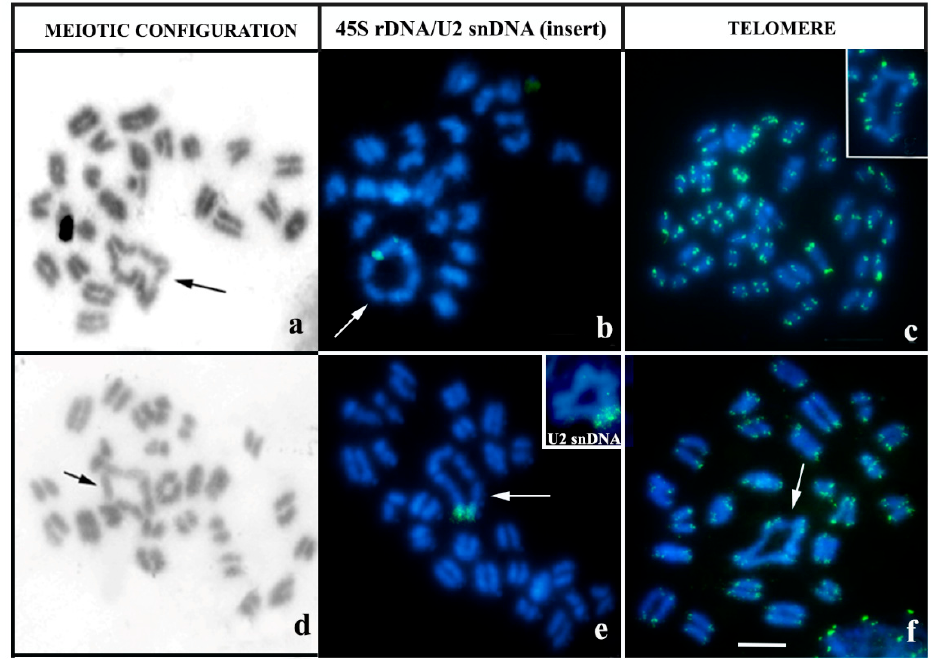
Figure 2. Multi-chromosomal meiotic associations in individuals of B. amazonicus cytotype B: ( a ) Hexavalent (arrow) stained-giemsa; ( b ) FISH with 45S rDNA probe in hexavalent (arrow); ( c ) FISH with telomeric probe in individual with hexavalent (insert); ( d ) quadrivalent (arrow) stained-giemsa; ( e ) FISH with 45S rDNA probe (arrow) and U2 snDNA (insert) in quadrivalent; ( f ) FISH with telomeric probe in individual with quadrivalent. Bar = 10 μ m.